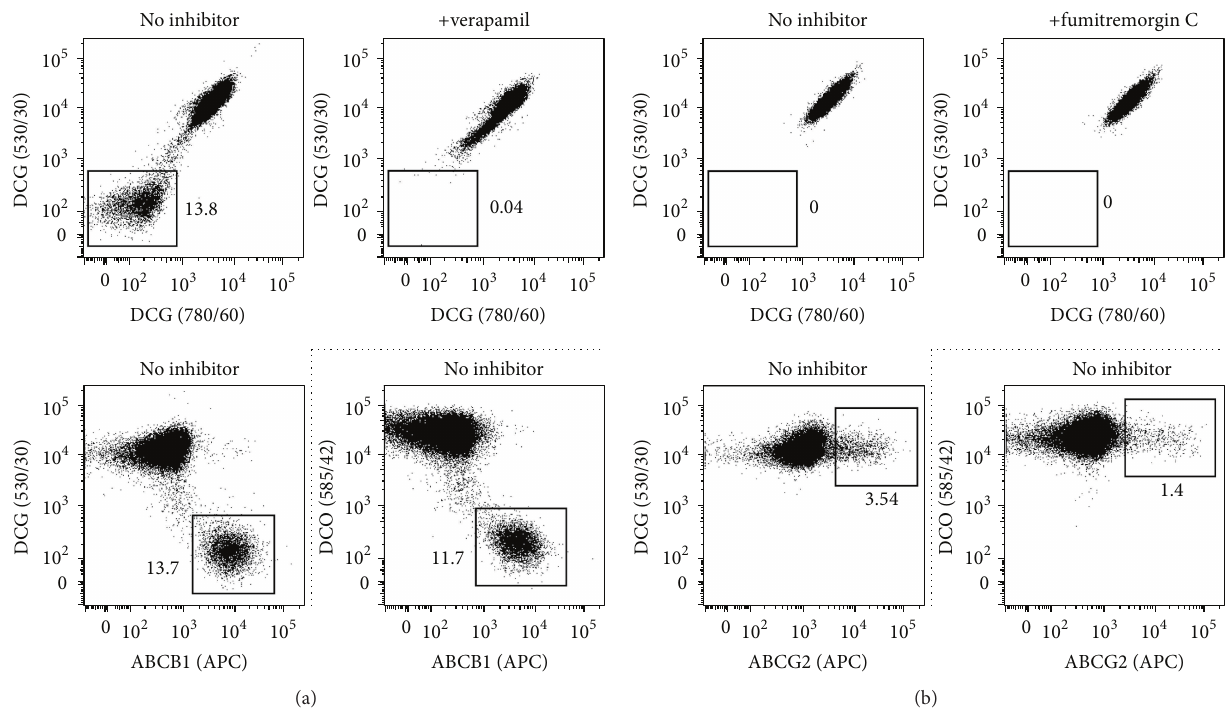
Figure 8: SP detection using the second-generation DyeCycle dyes DCG and DCO. A2780V cells harbouring an ABCB1-positive SP (a) and parental A2780 cells containing an ABCG2-positive SP (b) were stained with 500nM of either DCG or DCO (10 6 cells/mL) and analysed by flow cytometry using the indicated emission filters (DCO data accentuated by dotted lines). For control purpose, verapamil (A2780V) or fumitremorgin C inhibition (A2780) was performed, and drug transporters were stained with APC-conjugated monoclonal antibodies. Both DCG and DCO are able to detect ABCB1-positive SP cells, whereas neither dye can identify SP cells that express ABCG2. Note the extreme separation of ABCB1-SP cells, which made it impossible to measure the fluorescence